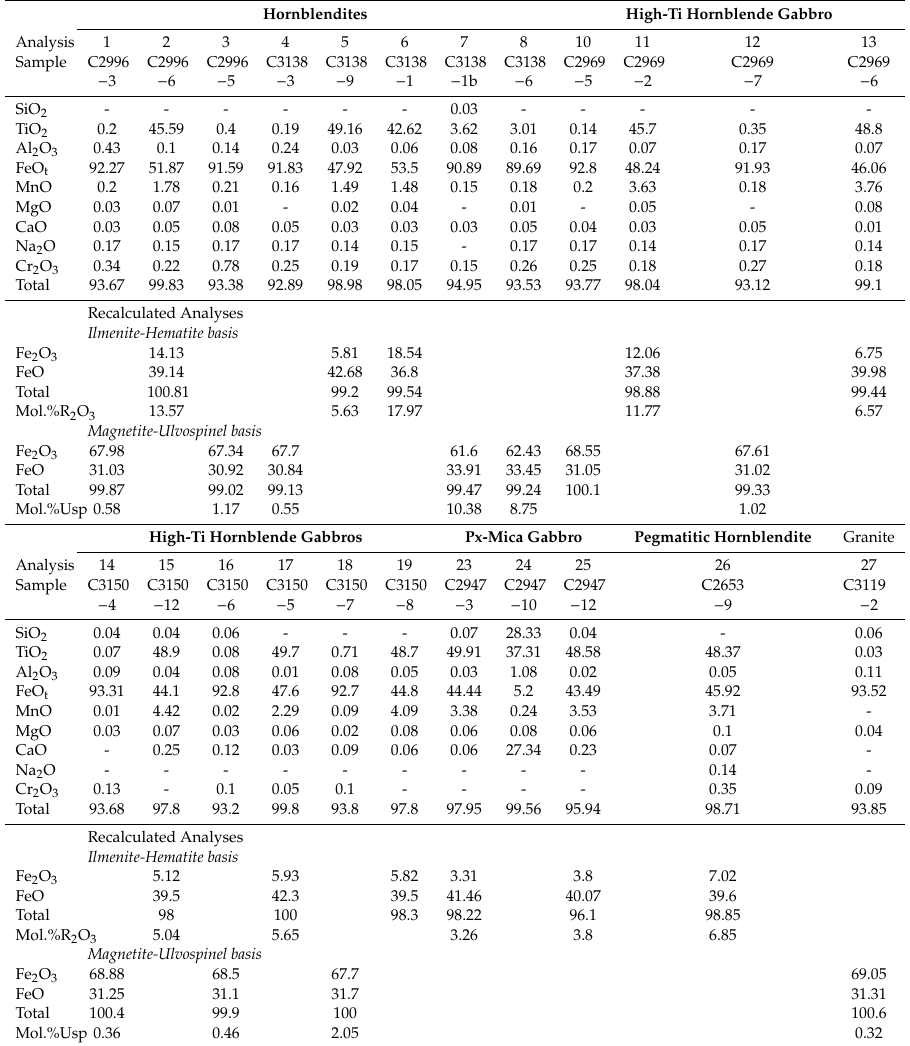
Table 2. Representative analyses of Fe–Ti oxides by electron